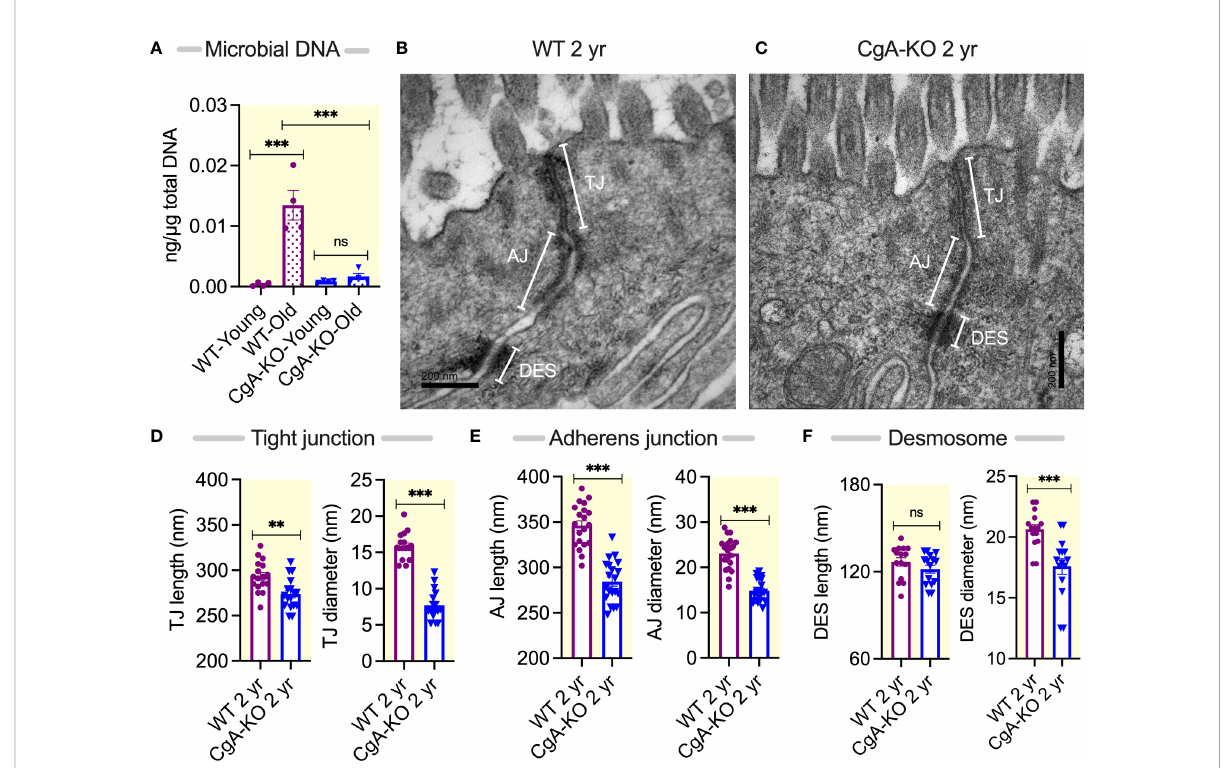
FIGURE 1 Age-associated changes in tissue bacterial DNA and gut barrier components. (A) Bacterial DNA in the heart of young (0.5 yr) and old (2 yr) WT and CgA-KO mice. (B, C) Electron micrographs showing gut barrier in colon of 2 yr old WT and CgA-KO mice. (D – F) Morphometric analyses of the gut barrier showing the lengths and diameters of tight junctions (D) , adherens junction (E) , and desmosomes (F) . AJ, adherens junction; Des, desmosomes; MV, microvilli; TJ, tight junction. **P <0.01; ***P